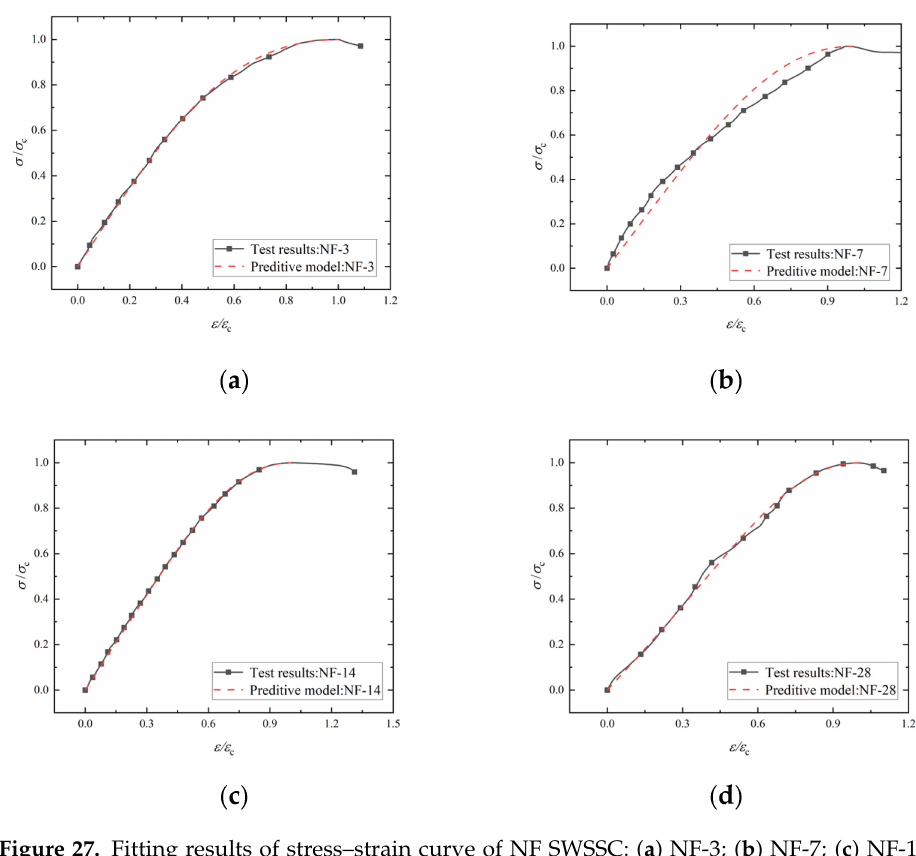
Figure 27. Fitting results of stress–strain curve of NF SWSSC: ( a ) NF-3; ( b ) NF-7; ( c ) NF-14; and ( d ) NF-28.